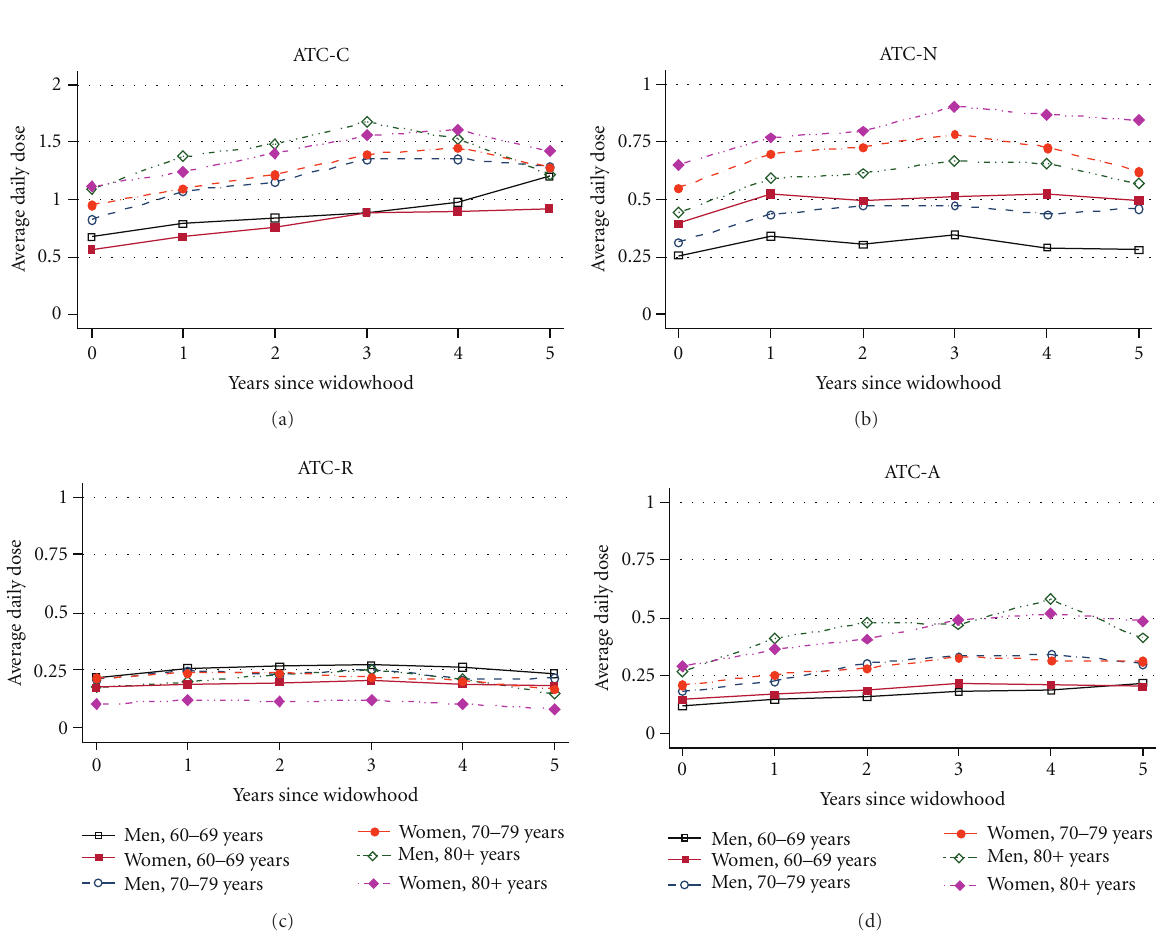
Figure 2: System-specific medication use before and after